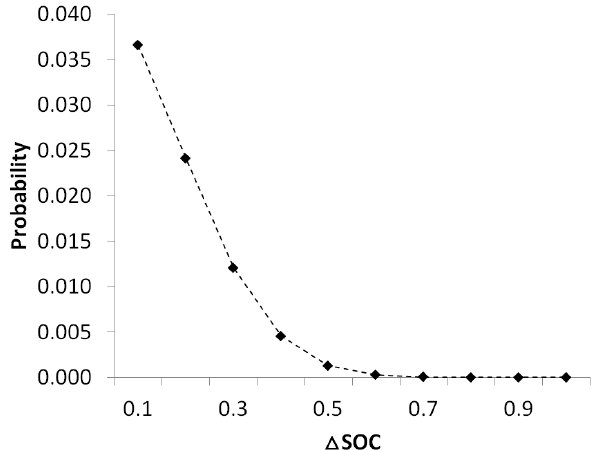
Figure 4. Probability distribution of SOC deviation for an hour by V2G regulation.